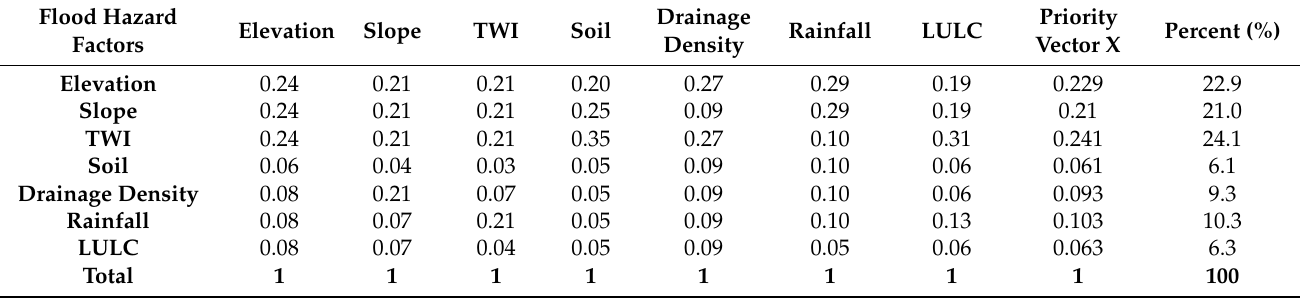
Table 2. Weighted comparison.